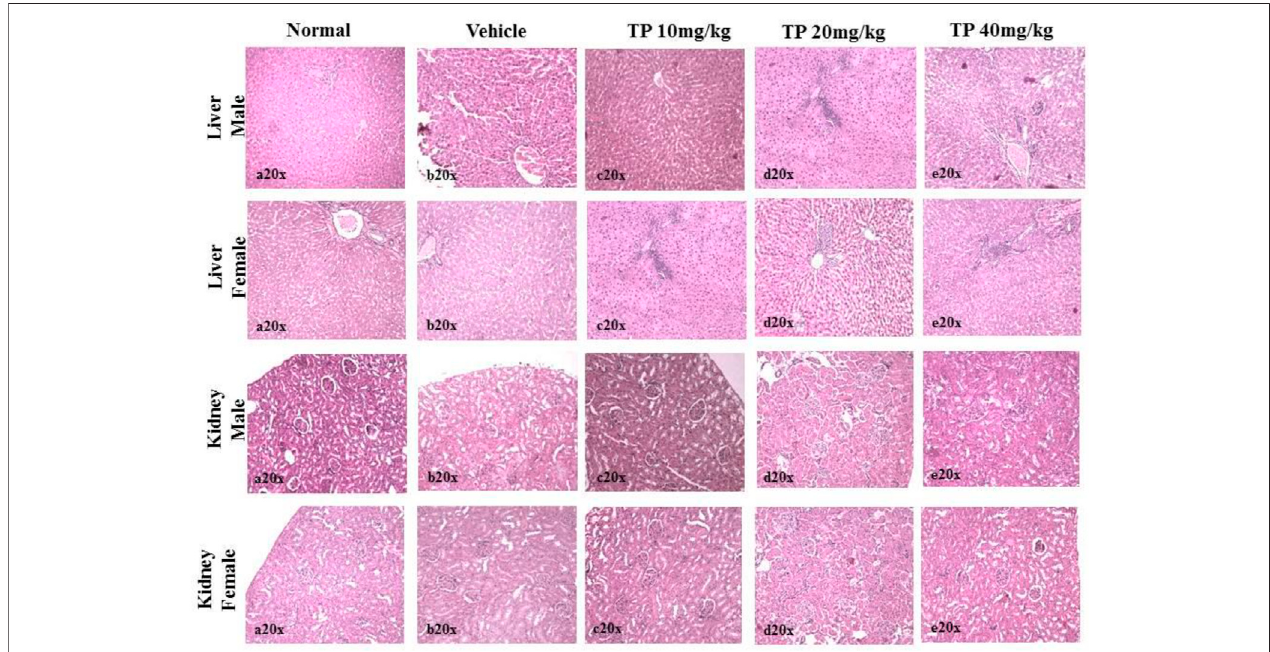
FIGURE 11 | Histopathological analysis of the liver showing no normal hepatocytes in control, vehicle, and low-dose TP-treated groups of both sexes. Mild portal in fl ammation observed in the mid-and high-dose TP-treated groups of male and female rats. Histopathological analysis of kidney tissues showed normal architecture of nephrons in the male and female SD rats after 28 days treatment of Thamira parpam.